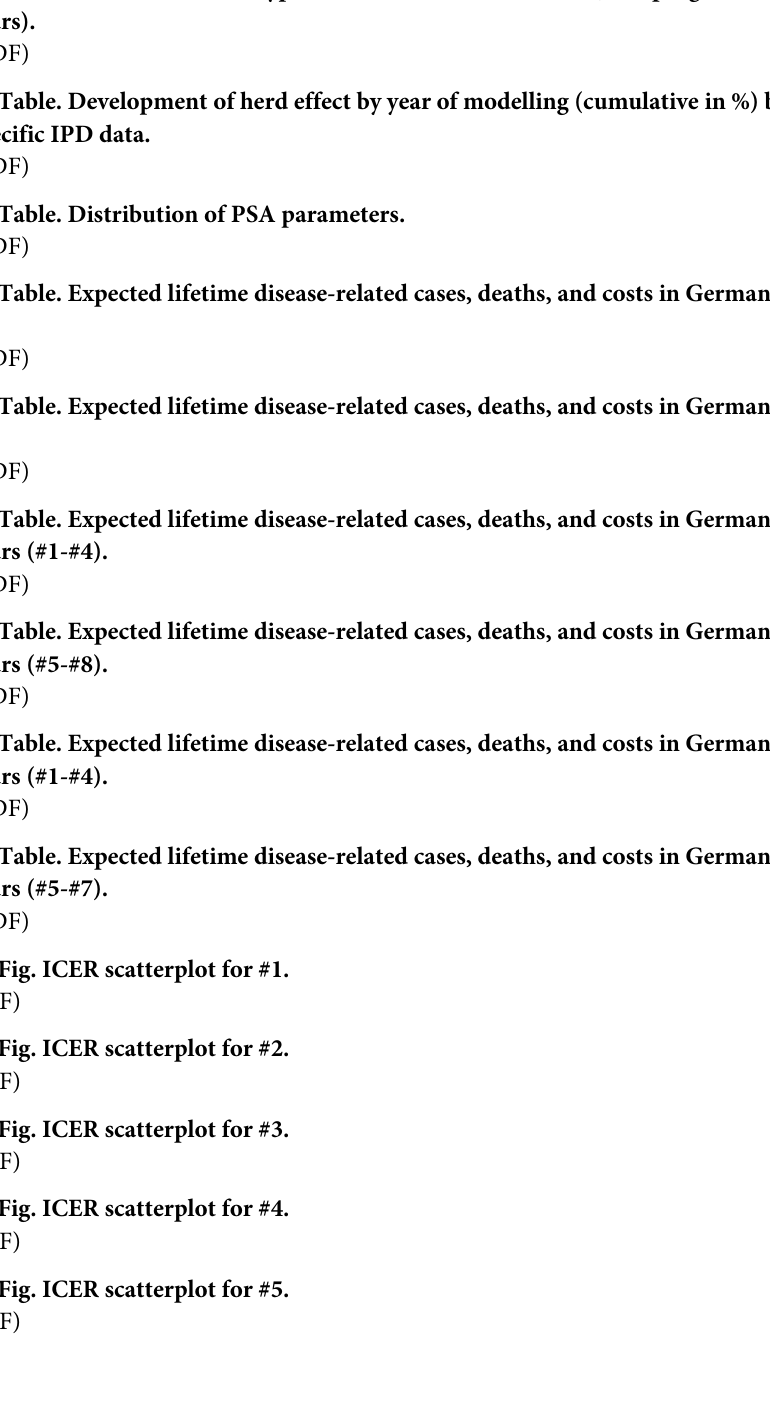
S1 Fig. ICER scatterplot for #1. S2 Fig. ICER scatterplot for #2. S3 Fig. ICER scatterplot for #3. S4 Fig. ICER scatterplot for #4. S5 Fig. ICER scatterplot for